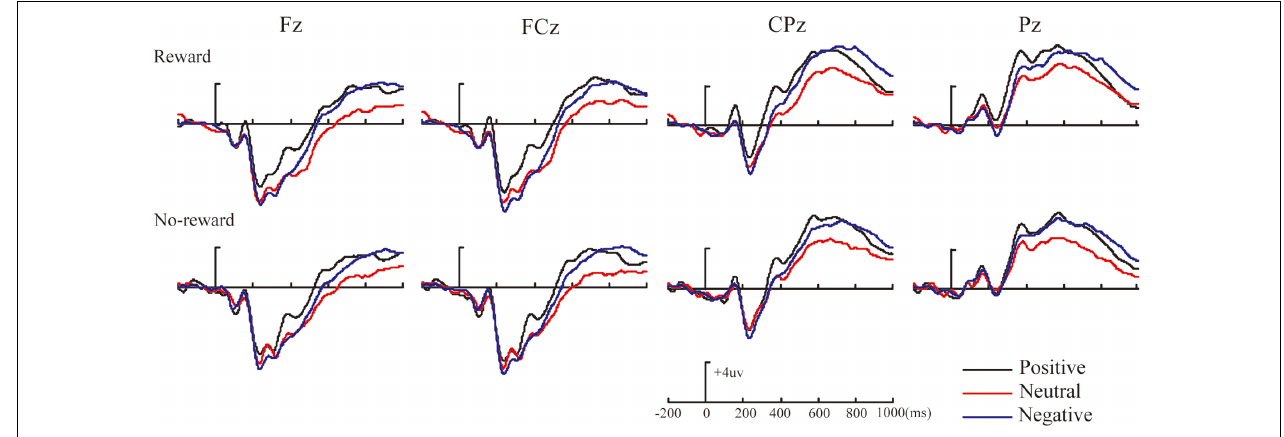
FIGURE 3 | The amplitude distribution of ERP about emotion effects in reward and no-reward items at Fz, FCz, CPz, and Pz.